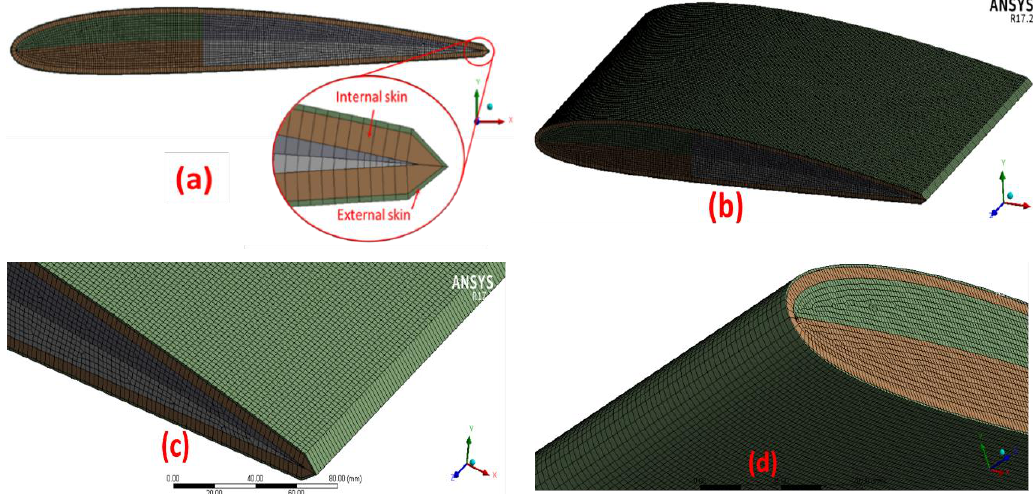
Figure 4. ( a ) FE (finite element) model of two-layered skin; ( b – d ) meshed model.